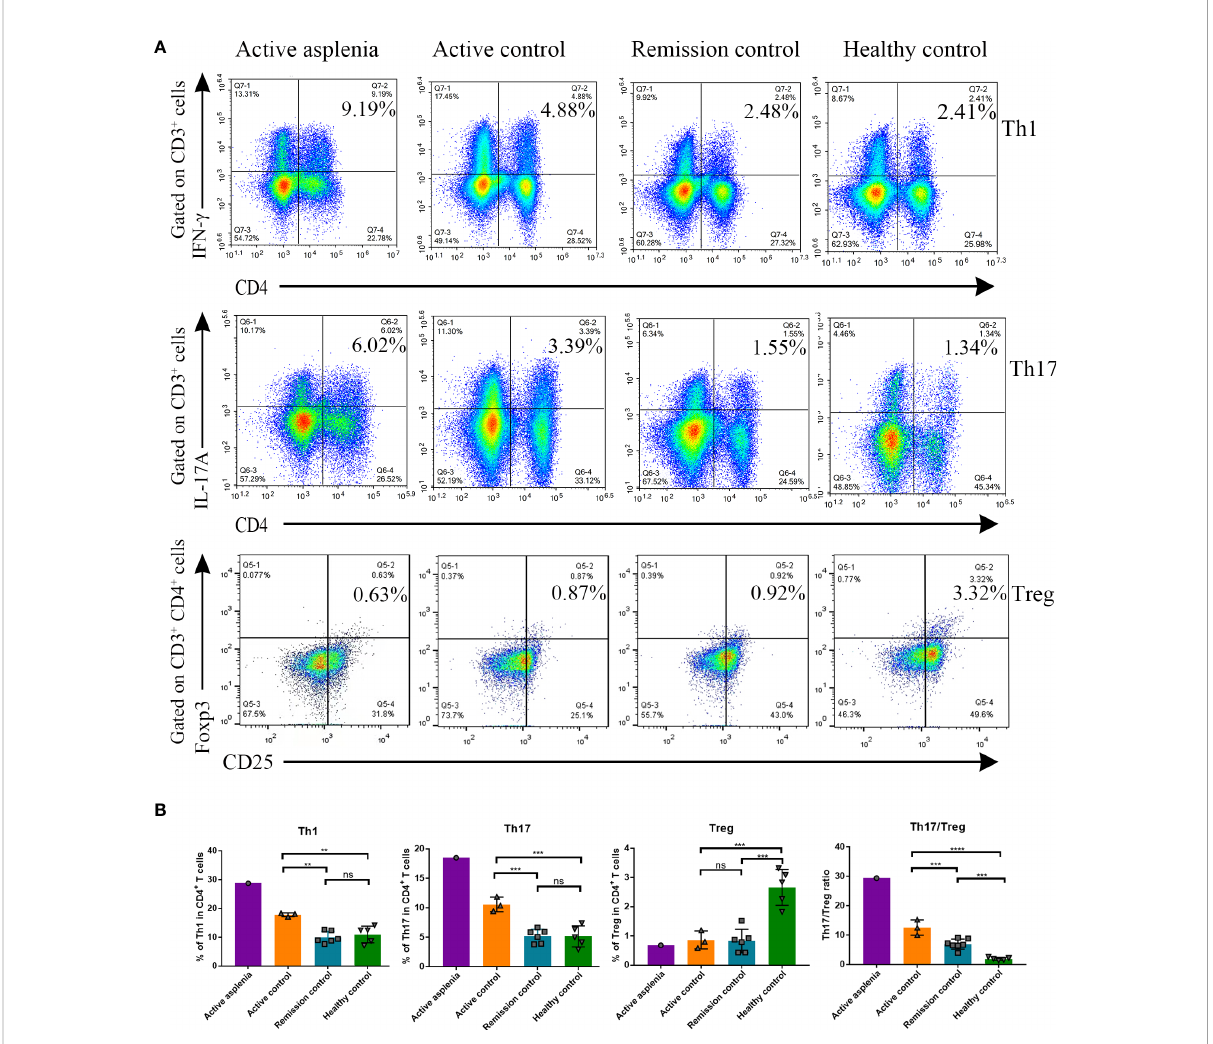
FIGURE 4 Flow cytometry analysis demonstrating the differences in proportions of Th1, Th17 and Treg cells from PBMC and the Th17/Treg ratio among healthy controls, remission controls, active controls and the congenitally asplenic patient with active CD. (A) Representative FACS plots showing the percentage of CD3 + CD4 + IFN- g + (Th1) cells (top panel: gated on CD3 + cells), CD3 + CD4 + IL-17A + (Th17) cells (middle panel: gated on CD3 + cells) and CD3 + CD4 + CD25 + Foxp3 + (Treg) cells (bottom panel: gated on CD3 + CD4 + cells) of each group [asplenia with active CD (n=1), controls with active CD (n=3), controls with remission CD (n=6), healthy controls (n=5)]. (B) The histograms showing the difference in the percentage of Th1, Th17 and Treg cells in CD4 + T cell, as well as the Th17/Treg ratio. Data were analyzed by One-way ANOVA, and all values are reported as means and SD. ns, not signi fi cant; **P < 0.01; ***P < 0.001; ****P <